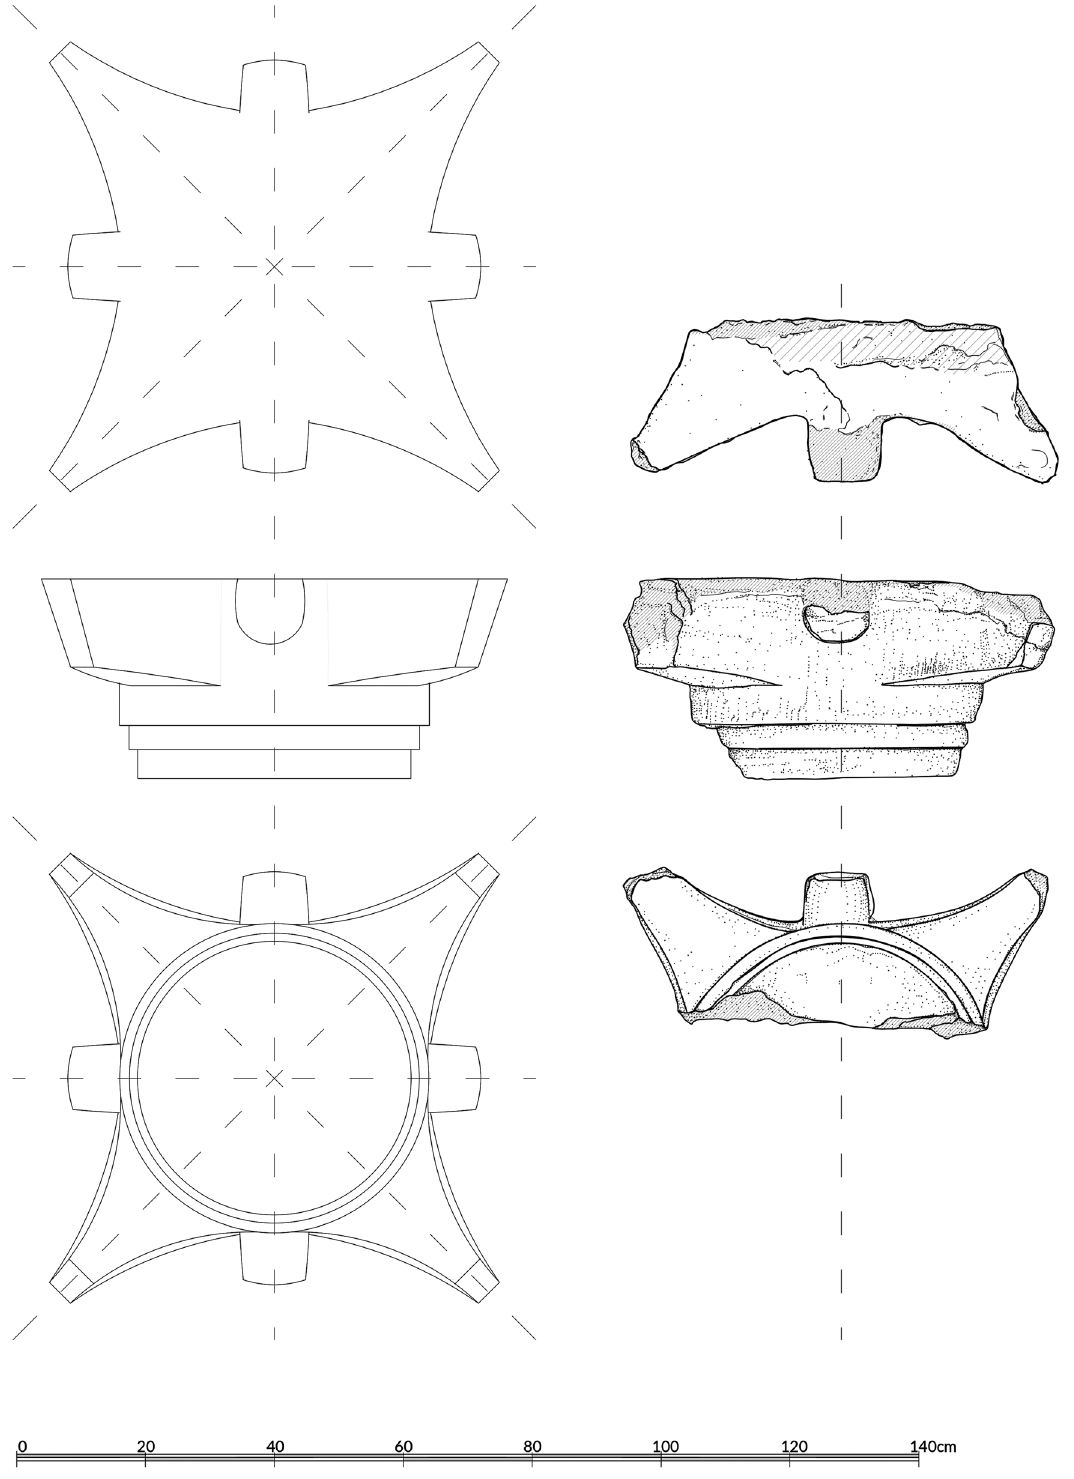
Figure 7: Blocked - out capital from Berenike trench BE19 - 122: left, reconstruction; right, existing state of preservation ( F. Mi, S. Pop ł awski )